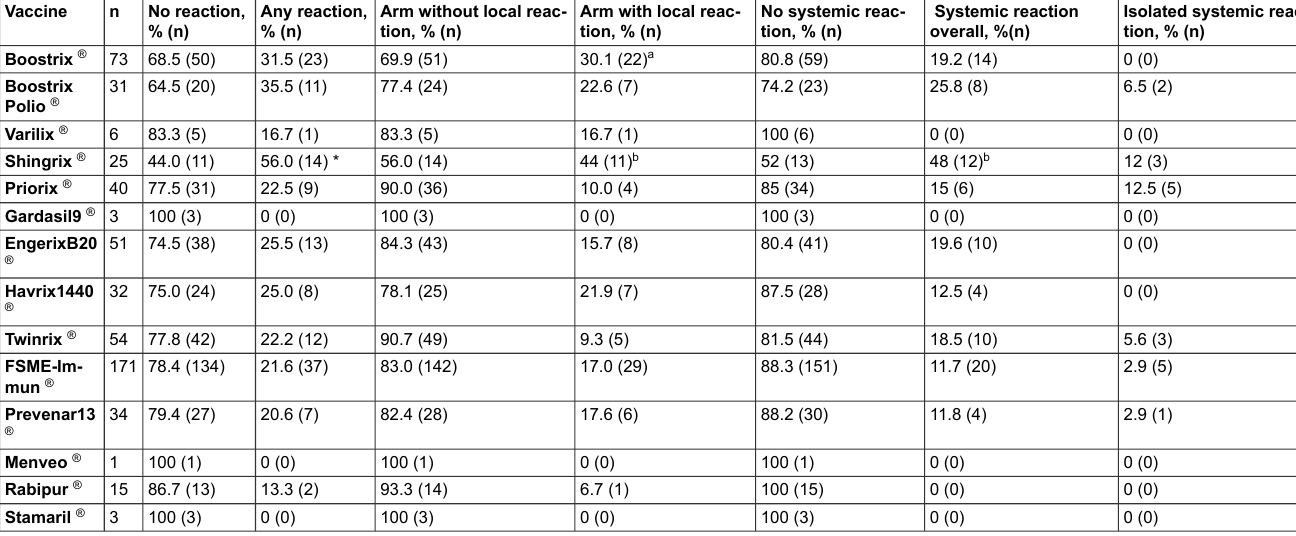
Comparison of reported AEFI after each vaccine compared to the group of all other vaccines combined. The following differences were statistically significant: a Boostrix ® is associated with local AEFI more often than average (p = 0.015).